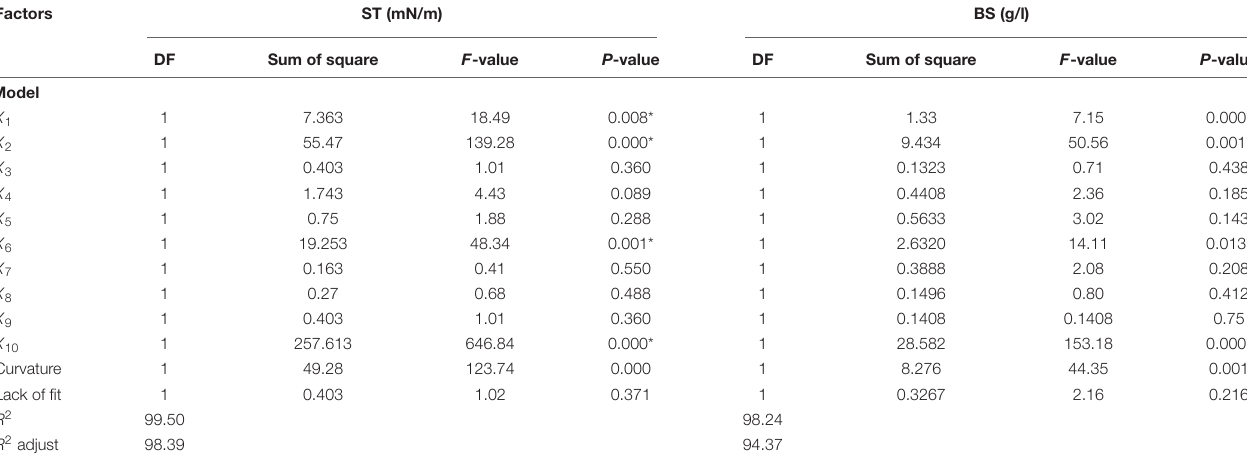
TABLE 2 | Analysis of variance (ANOVA) for surface tension (ST) and produced biosurfactant (BS) as the response variables based on Plackett–Burman experiment. Factors ST (mN/m) BS